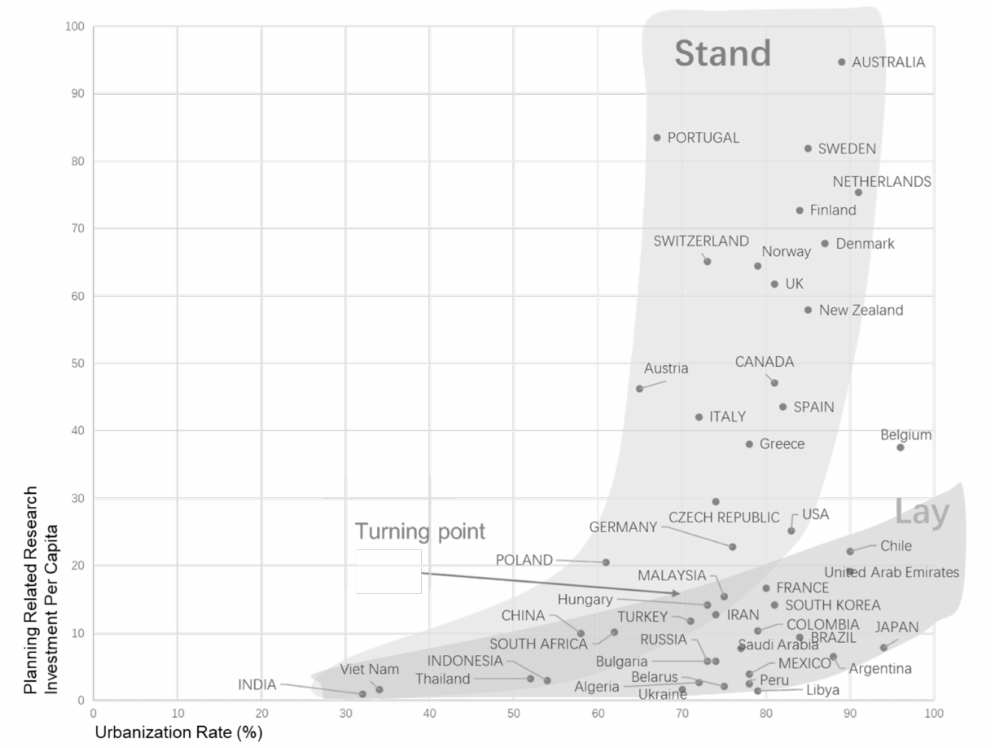
Figure 4. Planning research input and urbanization path choice [30]. Source: based on data from Web of